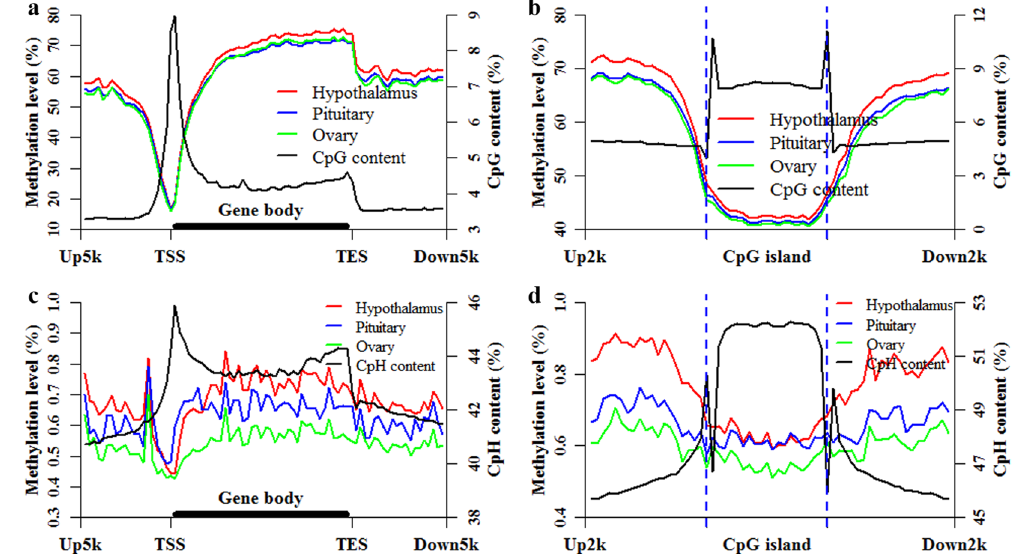
Figure 2. Methylation and density patterns of CpGs and CpHs at CGI and gene locations. Methylation and density patterns of CpG sites at the locations of genes ( a ) and CGIs ( b ). Methylation and density patterns of CpH sites at the locations of genes ( c ) and CGIs ( d ).